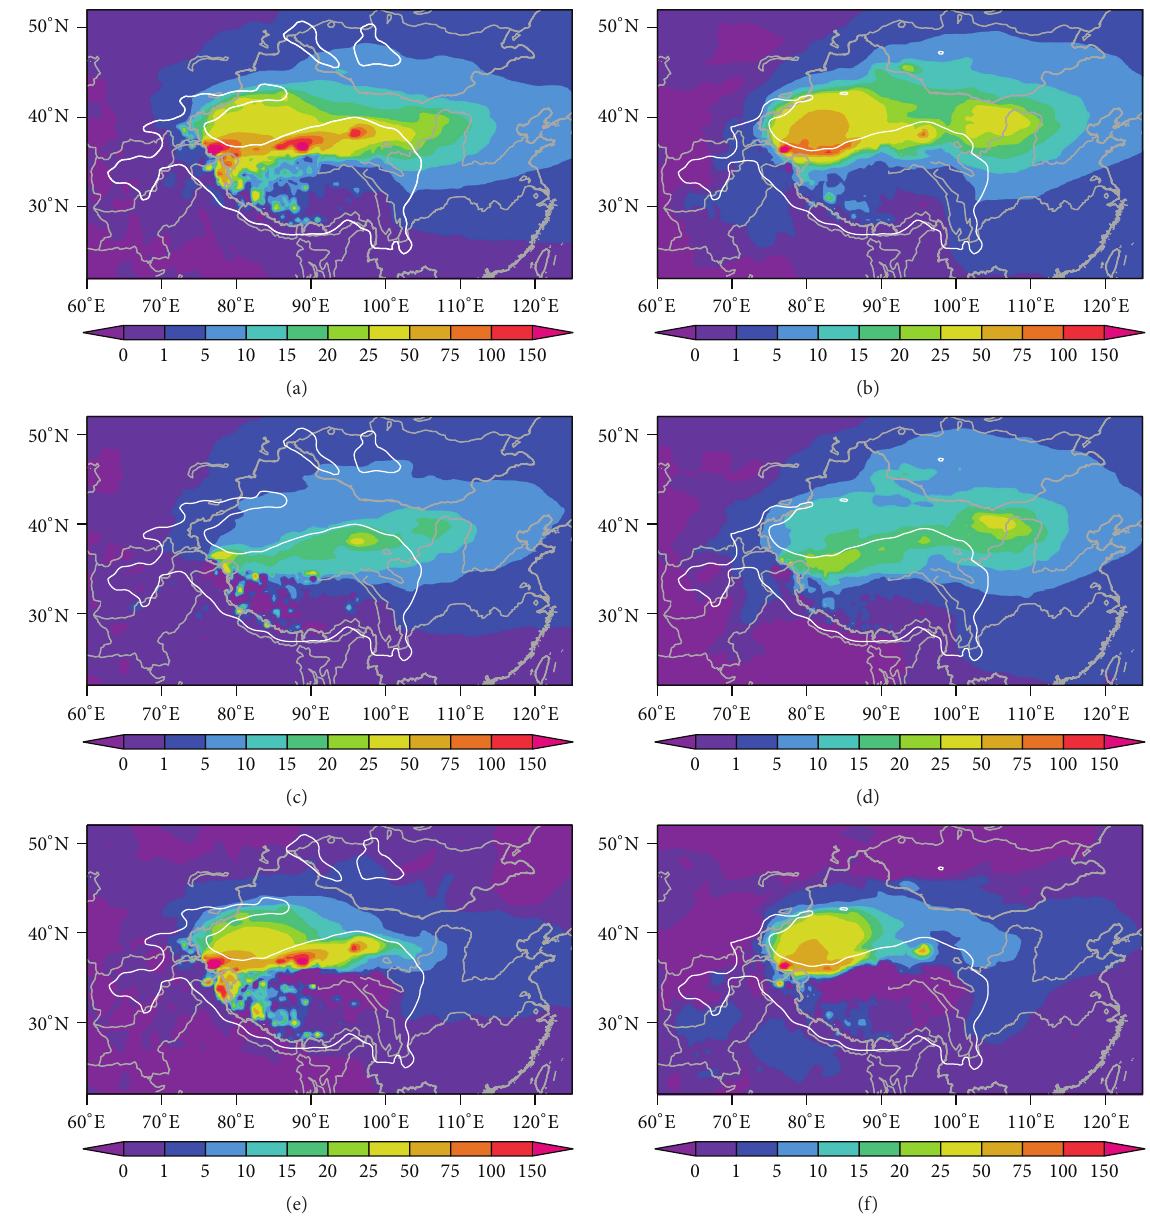
Figure 6: Dust mixing ratio changes at 600hPa ( 𝜇 g kg −1 ) between different numerical experiments in spring (a, c, e) and summer (b, d, f): (a, b) HMD − HM; (c, d) LMD − LM; (e, f) (HMD − HM) minus (LMD −